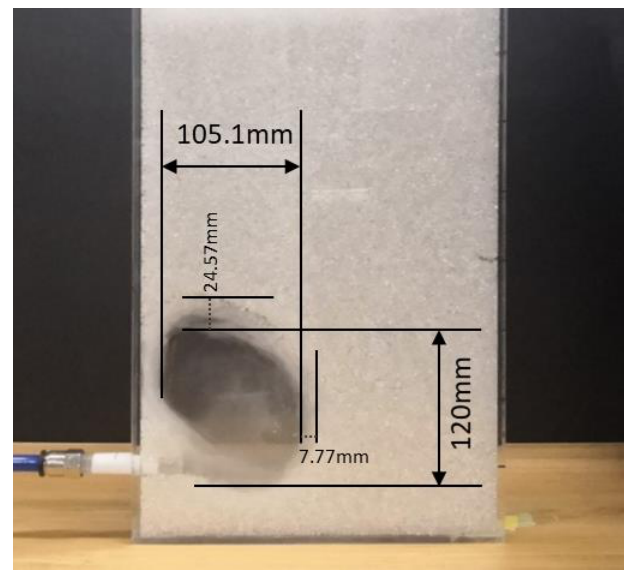
Figure A2. The void depth and height in the experiment